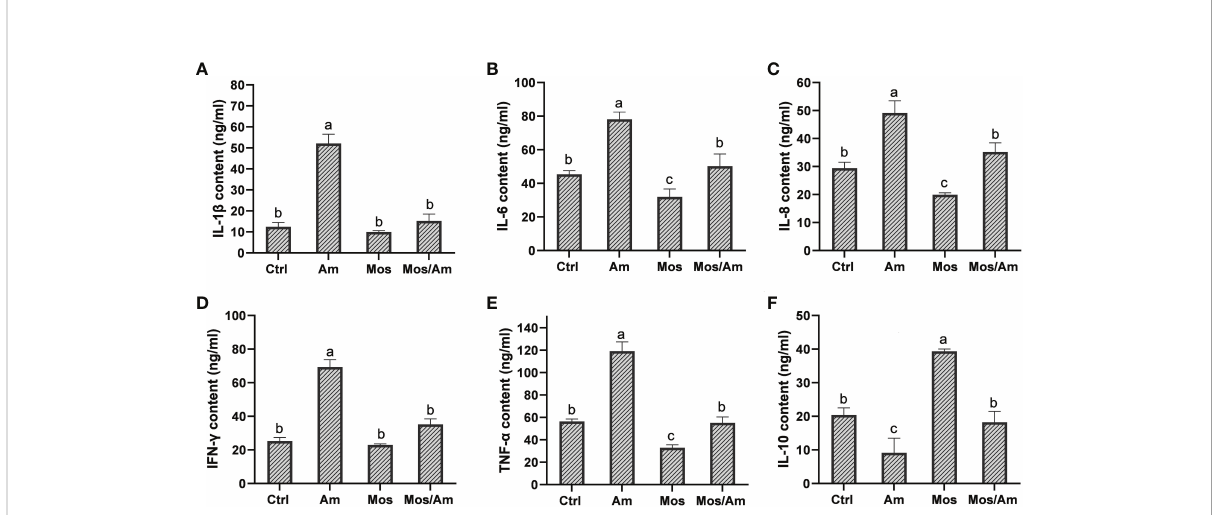
FIGURE 3 Effects of dietary MOS on the activity levels of in fl ammatory factors of the common carp under ammonia stress for 30 days. Values are expressed as mean ± standard error (SE) from triplicate groups. Bars with different letters differ signi fi cantly from those of other groups (P < 0.05). IL-1 b content (A) , IL-6 content (B) , IL-8 content (C) , IFN- g content (D) , TNF- a content (E) , IL-10 content (F)